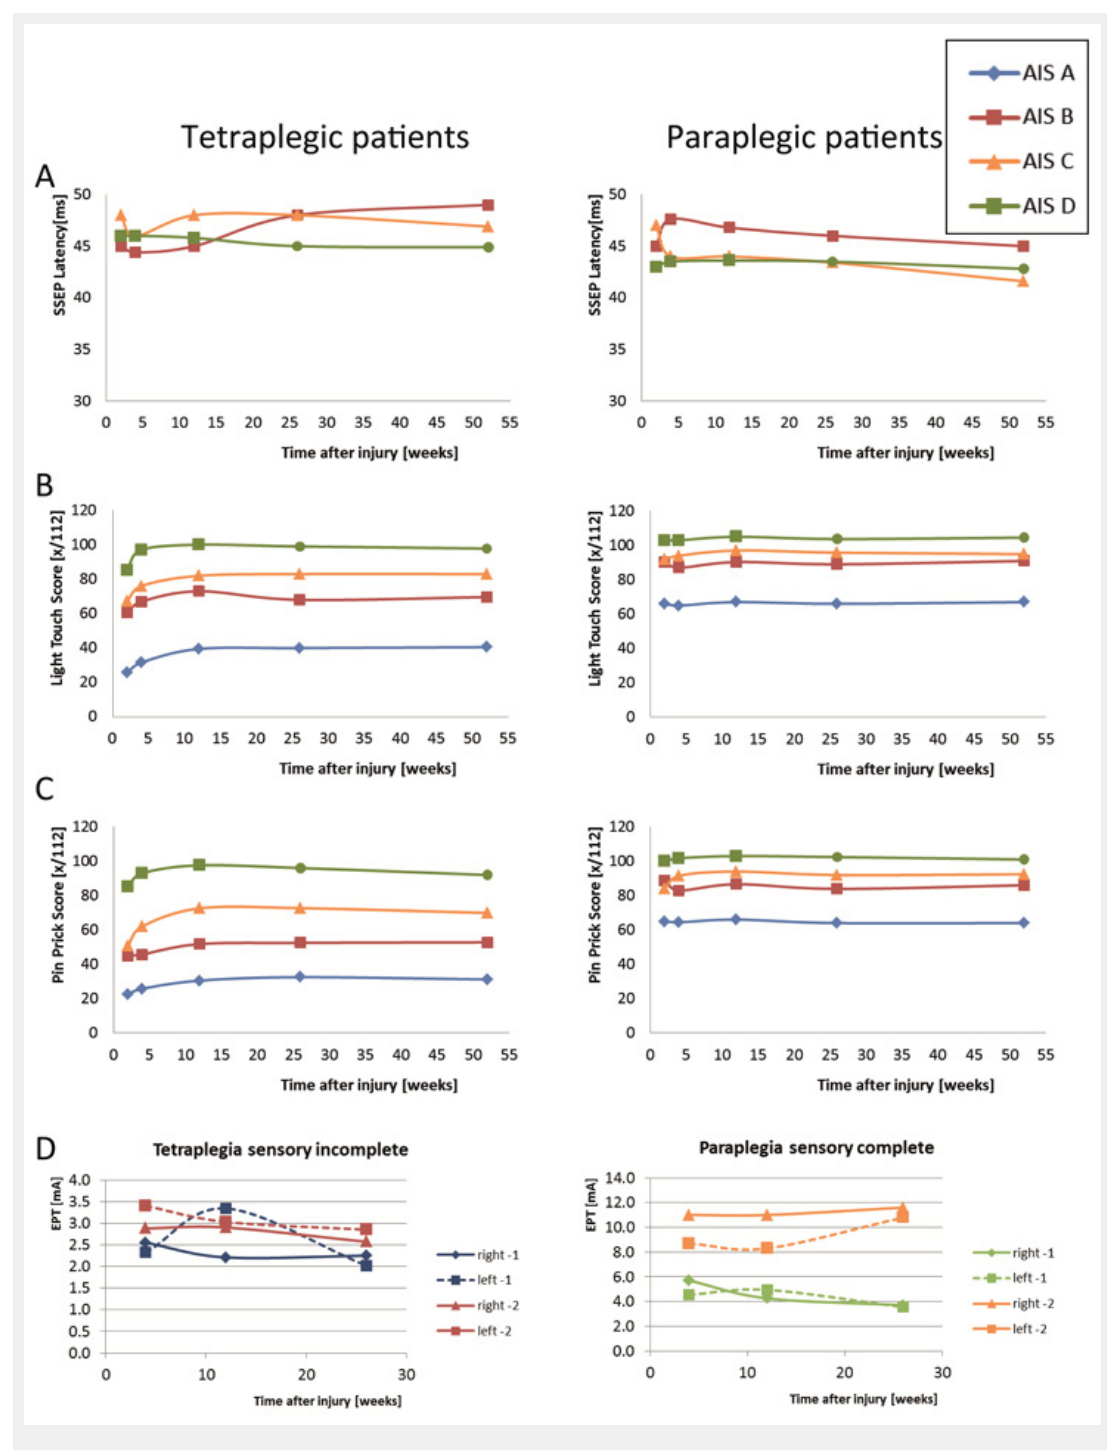
Improvement in sensory functions. Patterns of improvement in sensory functions are shown for patient groups, which are categorised according to the level of lesion (tetraplegic versus paraplegic patients) and ASIA Impairment Scale (AIS). Patterns are shown of (A) the latency of somato- sensory evoked potentials (SSEPs) elicited by electrical stimulation, (B) light touch and (C) pin prick sensation according to the International Standards. Numbers are based on [38]. (D) Changes in sensory perception as evaluated by the Electrical Perception Threshold (EPT) applied to the left and right dermatomes 1 and 2 segments below the neurological level of lesion (where most changes might be expected). Left: patients with a sensory incomplete tetraplegia; right: patients with a sensory-complete paraplegia. In both groups, there are no significant changes over time. (Numbers are based on